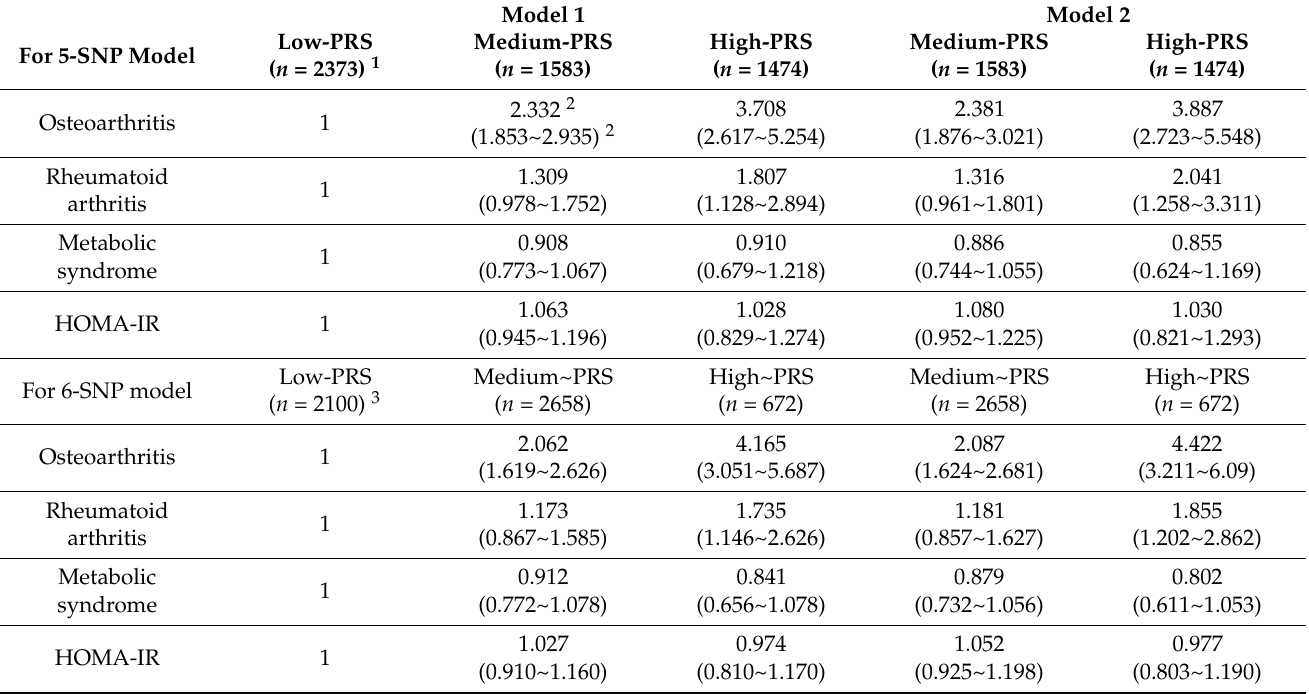
Table 4. Adjusted odds ratios for osteoarthritis according to the polygenetic risk scores of the best model (PRS) for gene–gene interaction after covariate